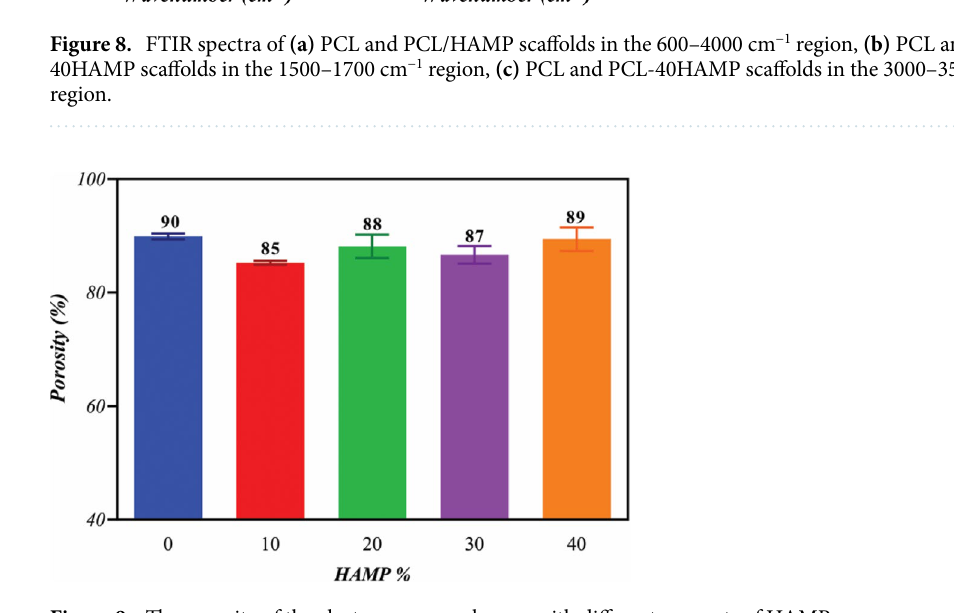
Figure 9. The porosity of the electrospun membranes with different amounts of